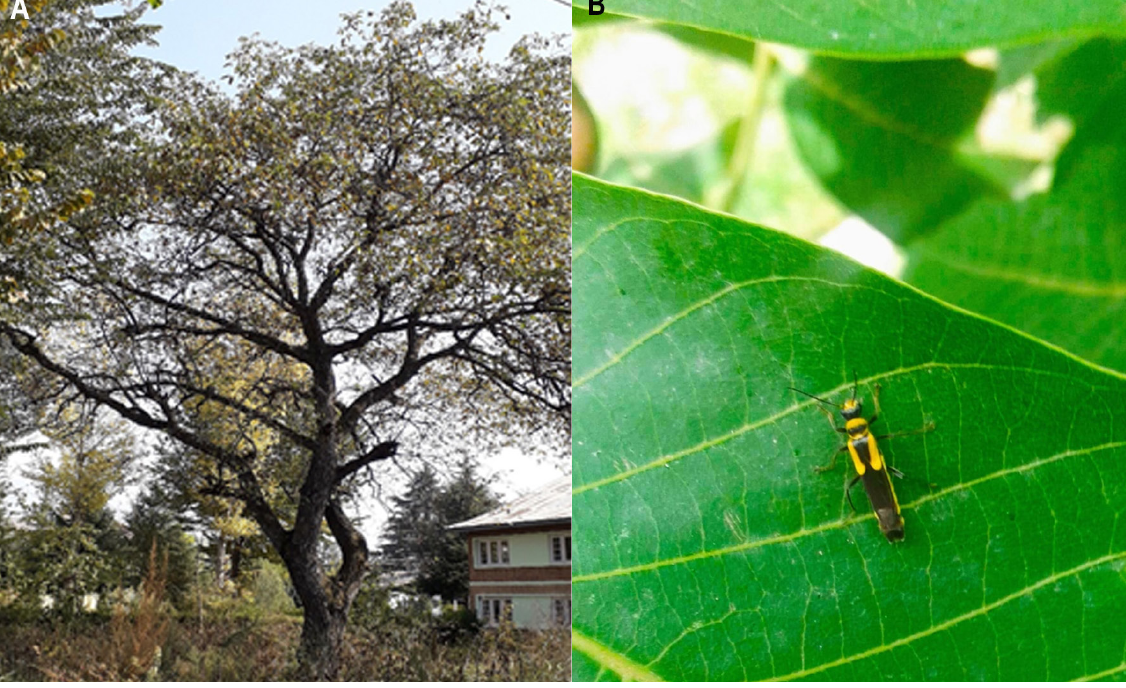
Fig. 1. Trypheridium kashmiricum sp. nov., ♀. A . Habitat ( Juglans regia L.). B . On a walnut